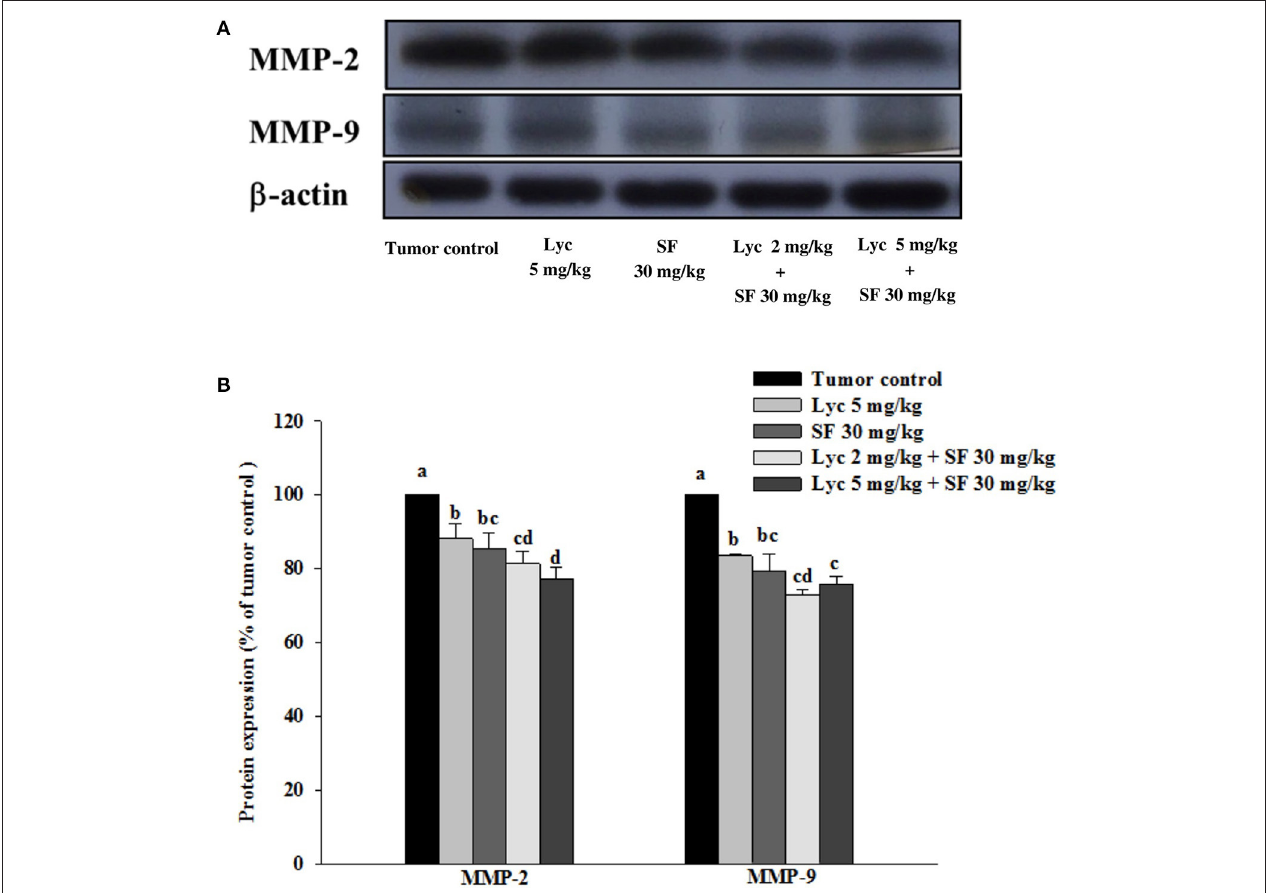
FIGURE 5 | Effects of lycopene (Lyc) alone, sorafenib (SF) alone, or their combination on MMP-9 and MMP-2 protein expressions in lung tissues of the C57BL/6 mice xenografted LLC cells. Nine days after tumor cell injection, the mice were orally supplemented with SF (30 mg/kg) daily, Lyc (2 and 5 mg/kg) twice per week or the combined treatment (mice were supplemented with SF (30 mg/kg) daily, and Lyc (2 and 5 mg/kg) twice per week) for 28 days. (A) Western blot analysis of MMP-9, MMP-2 and-actin. (B) Quantitative results of the protein expressions of MMP-9 and MMP-2. Data are means ± SD, n = 7 – 8; values not sharing an alphabetic letter are significantly different ( P <